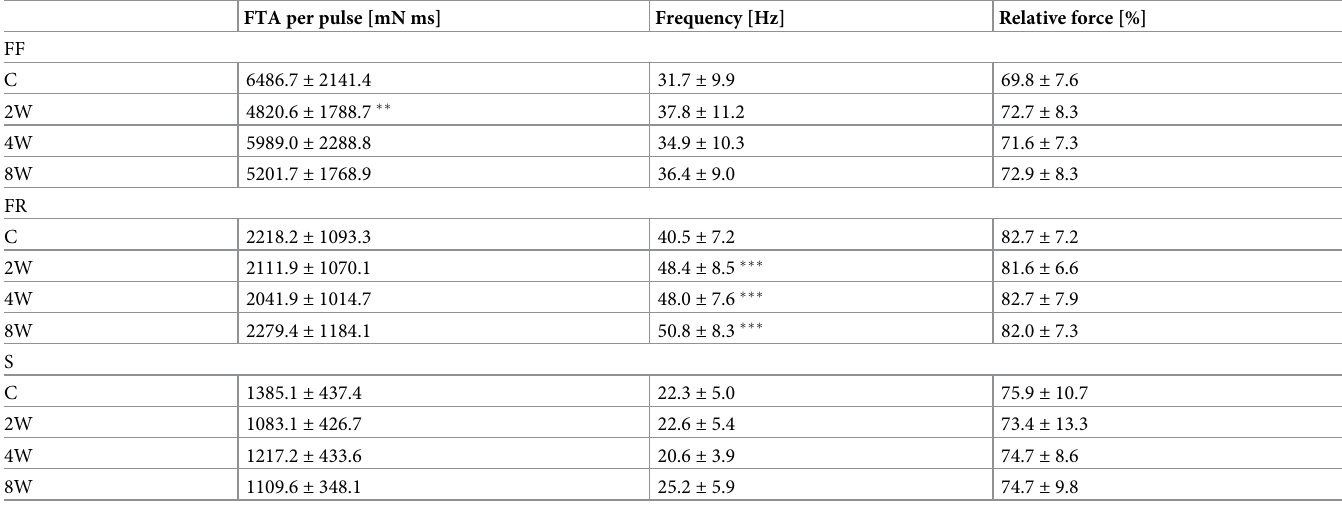
Table 3. The optimal tetanus in studied motor units in trained and control